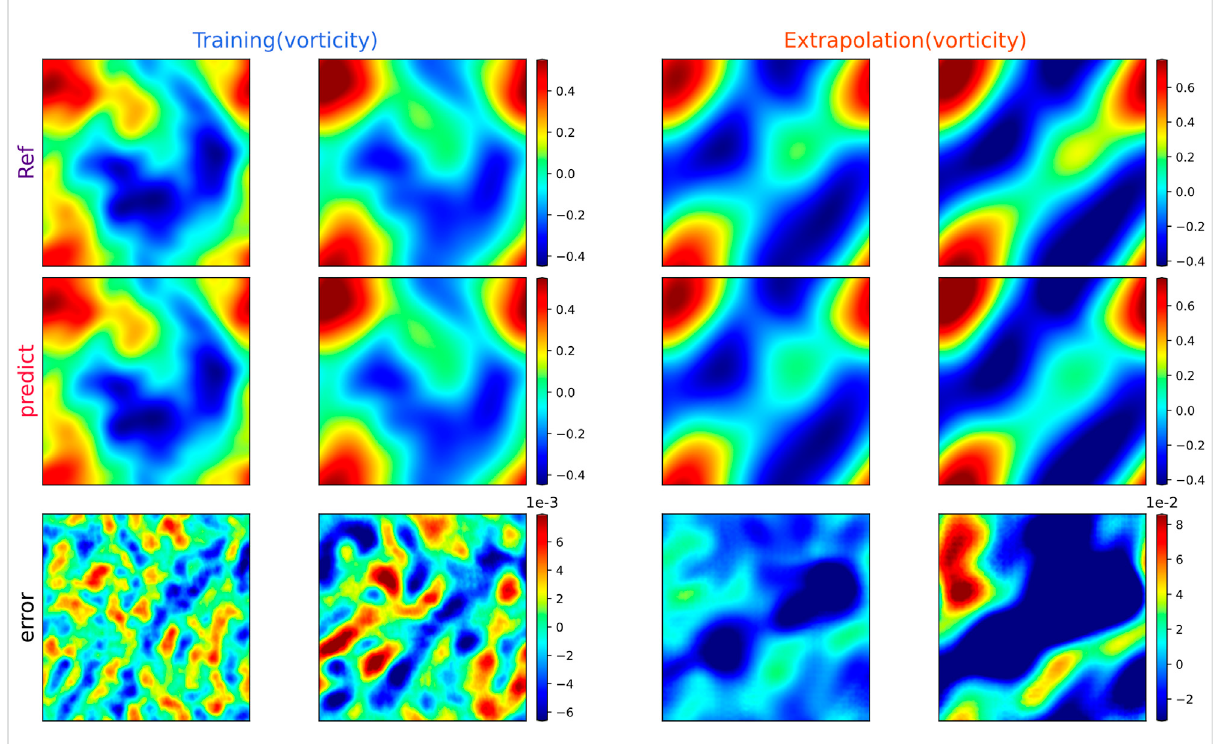
The vorticity fi eld results of Fourier fi lter-based PhyCRNet solving the 2D N_S equation. Four representative snapshots are selected as comparisons,namelytraining(t=0.5,1.5 s)andextrapolation(t=2.5,3.5 s),andcomparedtheerrorsovertheentireinterval.Fromtoptobottomare reference solutions, predictions and errors.